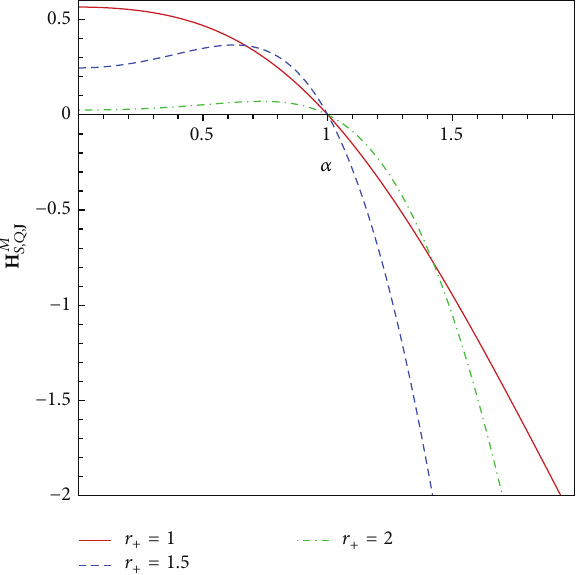
Figure 4: The behavior of H 𝑀 𝑆,𝑄, J versus 𝛼 with 𝑙 = 𝑏 = 1 , 𝑞 = 0.8 , Ξ = 1.25 , 𝑛 = 5 , and 𝛽 = 2 . Note that the curve corresponding to = 1 is rescaled by a factor 10 −1 𝑟 +